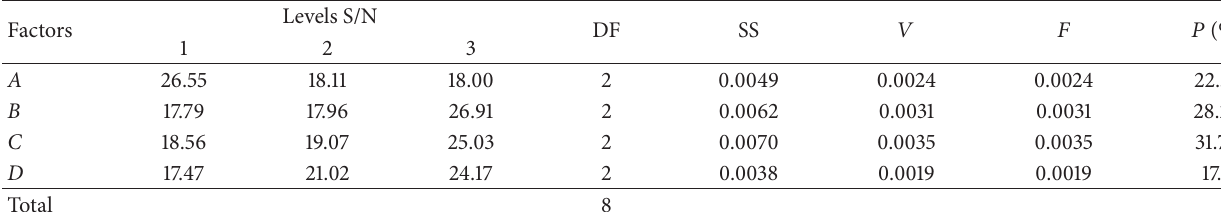
Table 8: ANOVA for specific wear rate.